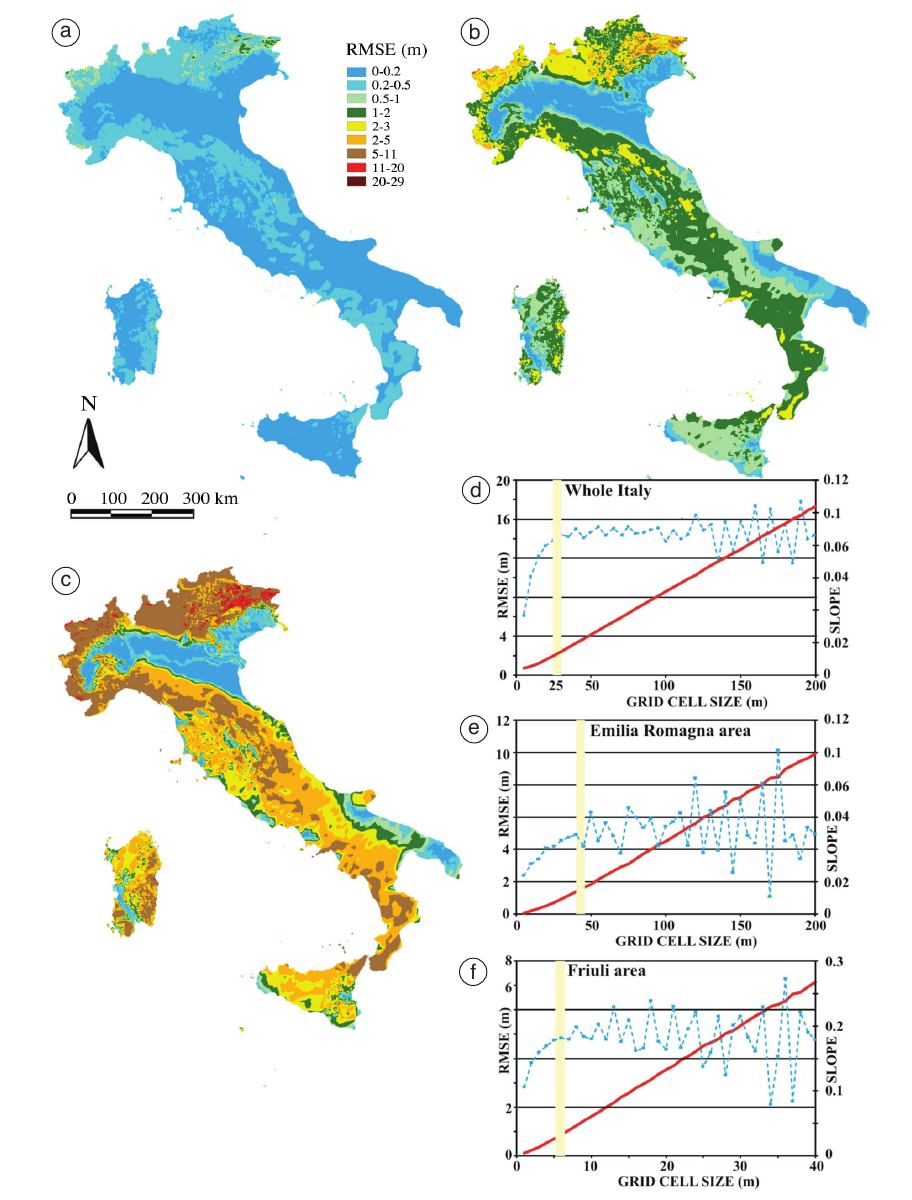
Fig. 10a-f. Distribution over the Italian territory of the RMSE derived from the transformation of the TINITALY/01 into a grid: a) map of the RMSE for a grid cell of 10 m; b) map of the RMSE for a grid cell of 40 m; c) map of the RMSE for a grid cell of 100 m; d) RMSE versus grid cell size diagram (solid red line) and its slope (dashed blue line) for the whole Italian territory; e) RMSE and its slope versus grid cell size diagram for the Emilia Romagna Re- gion; f) RMSE and its slope versus grid cell size diagram for the Friuli Venezia Giulia Region. In all the cases, the estimated RMSE shows two different trends at a threshold marked in the figures by a vertical yellow